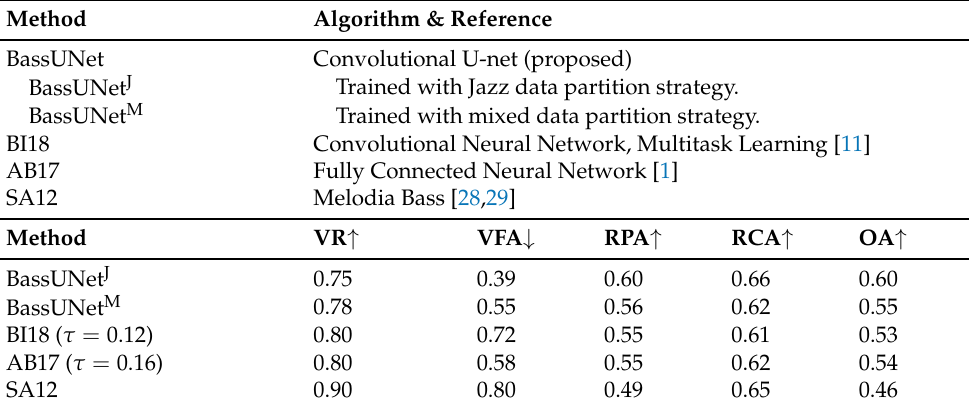
Table 6. Brief description of all evaluated bass transcription algorithms (top) and average file-level scores on the test set (bottom). Optimal minimum salience thresholds τ for BI18 and AB17 obtained on the validation set are given in